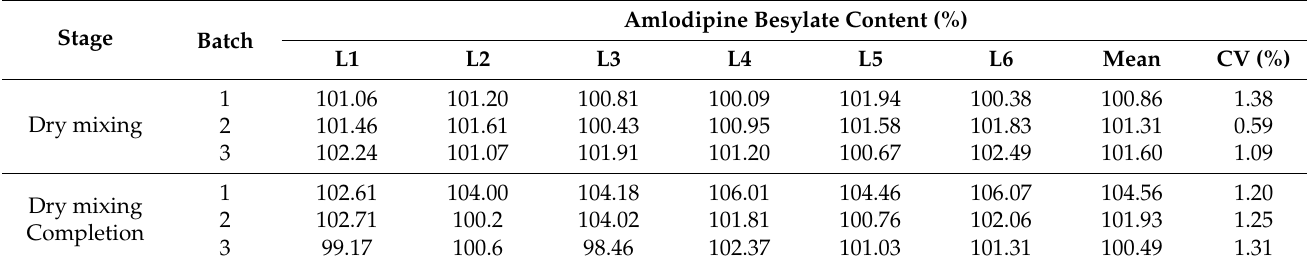
Table 6. Optimal process of amlodipine besylate layer in three